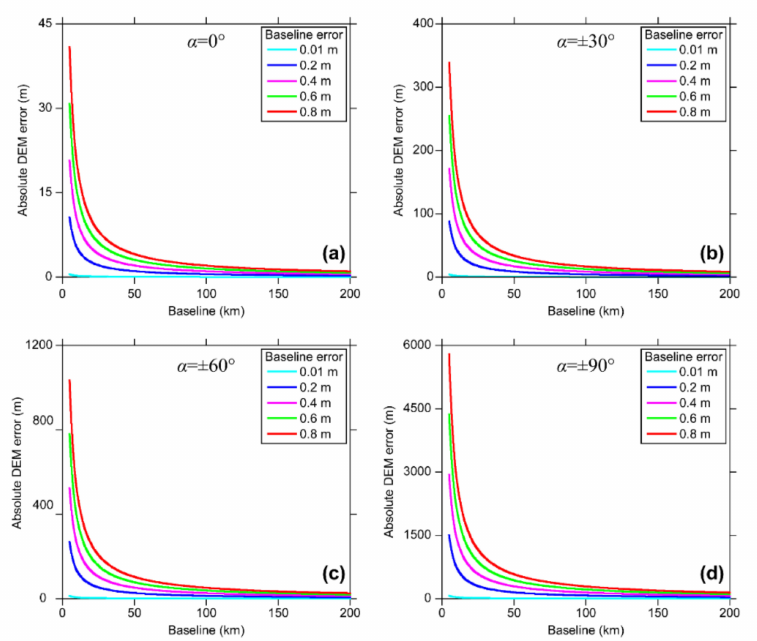
Figure 9. DEM errors due to baseline errors with respect to different spatial baselines and baseline inclination angles (i.e., 0 ◦ , ± 30 ◦ , ± 60 ◦ , and ± 90 ◦ for ( a − d )). Nominal look angle of 4.8 ◦ is used